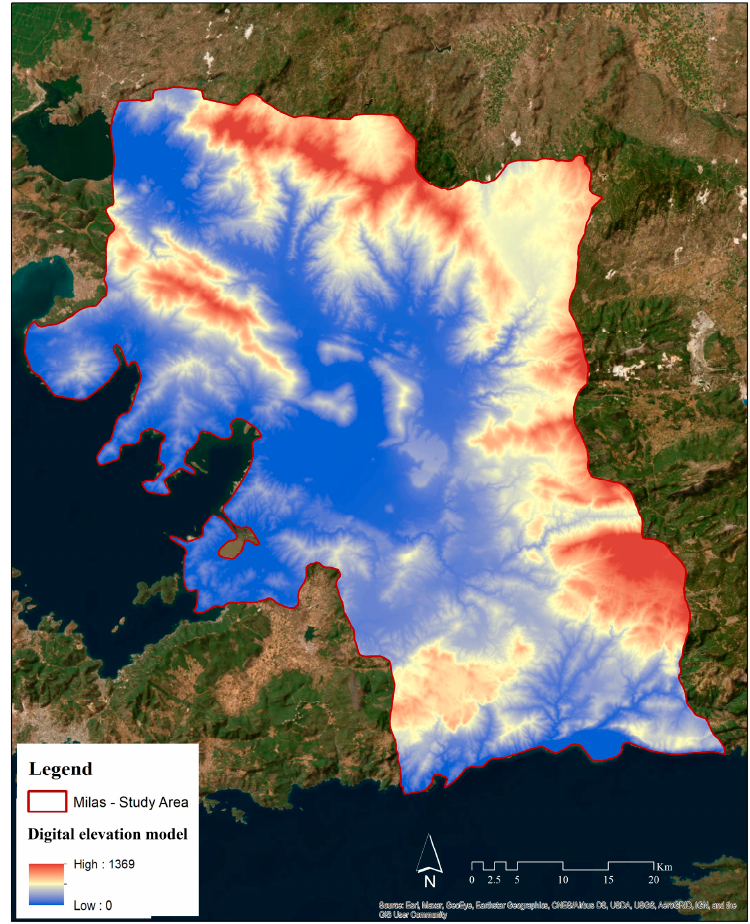
Figure 13. Elevations (m).